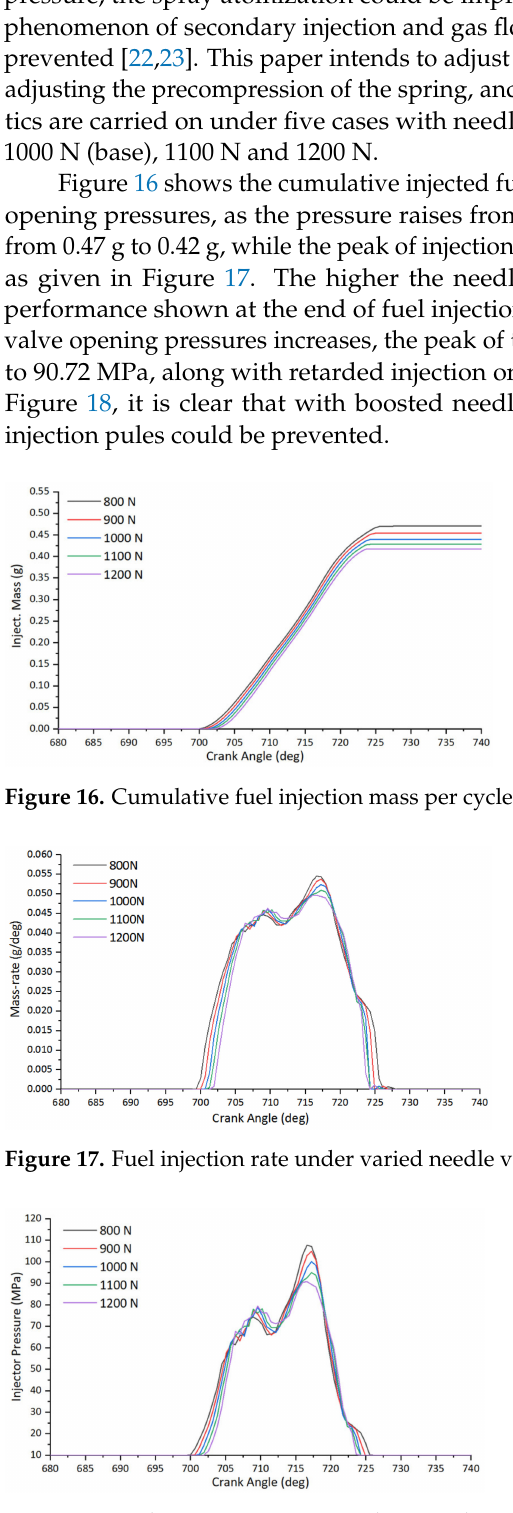
Figure 18. Fuel injection pressure under varied needle valve opening